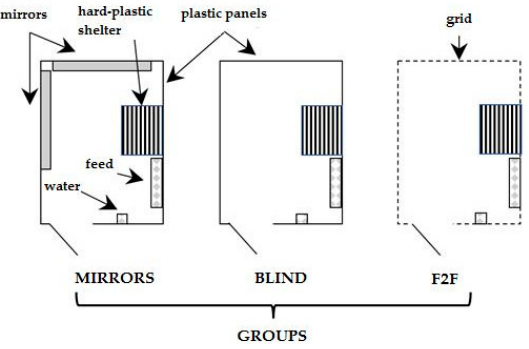
Figure 1. Design of the pens for Mirrors, Blind and Face to Face (F2F) groups.